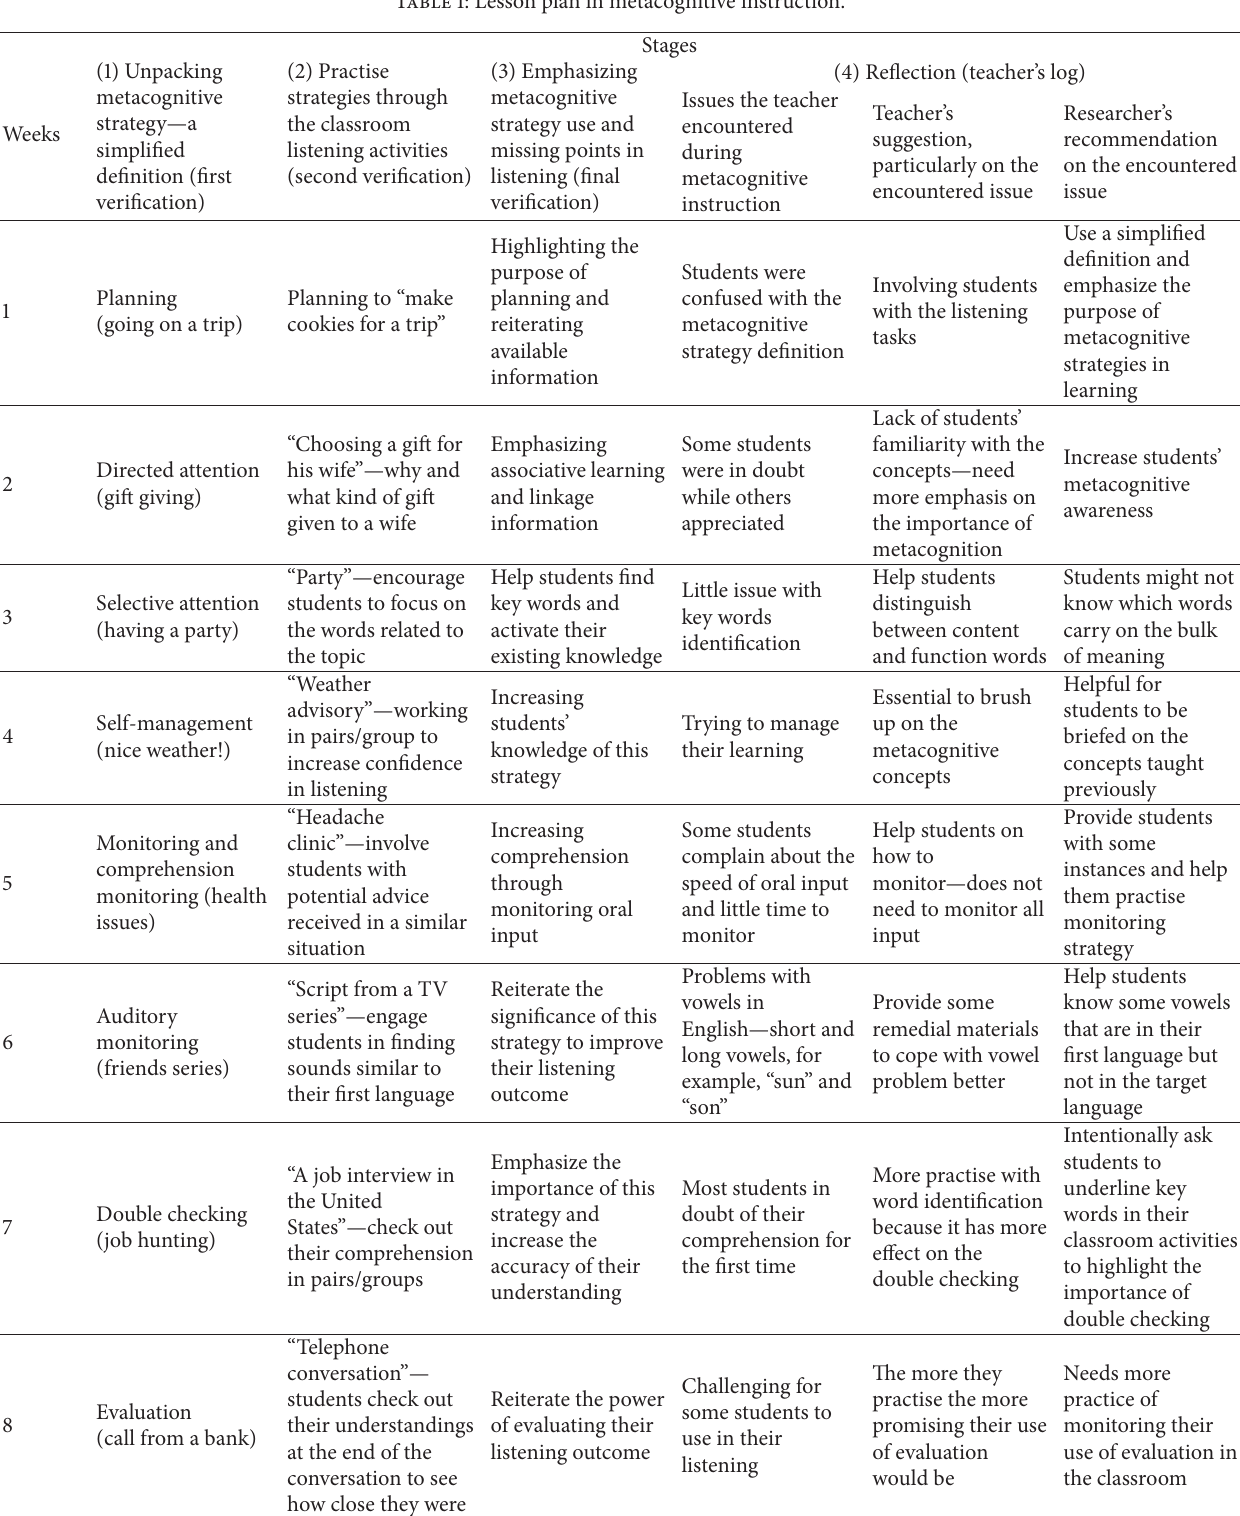
Table 1: Lesson plan in metacognitive